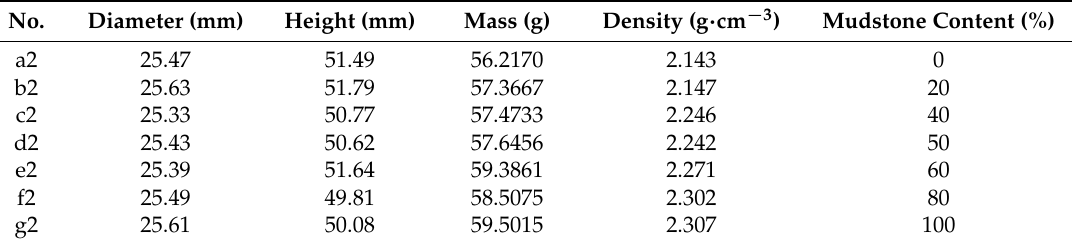
Table 3. Physical parameters of layered rock salt.